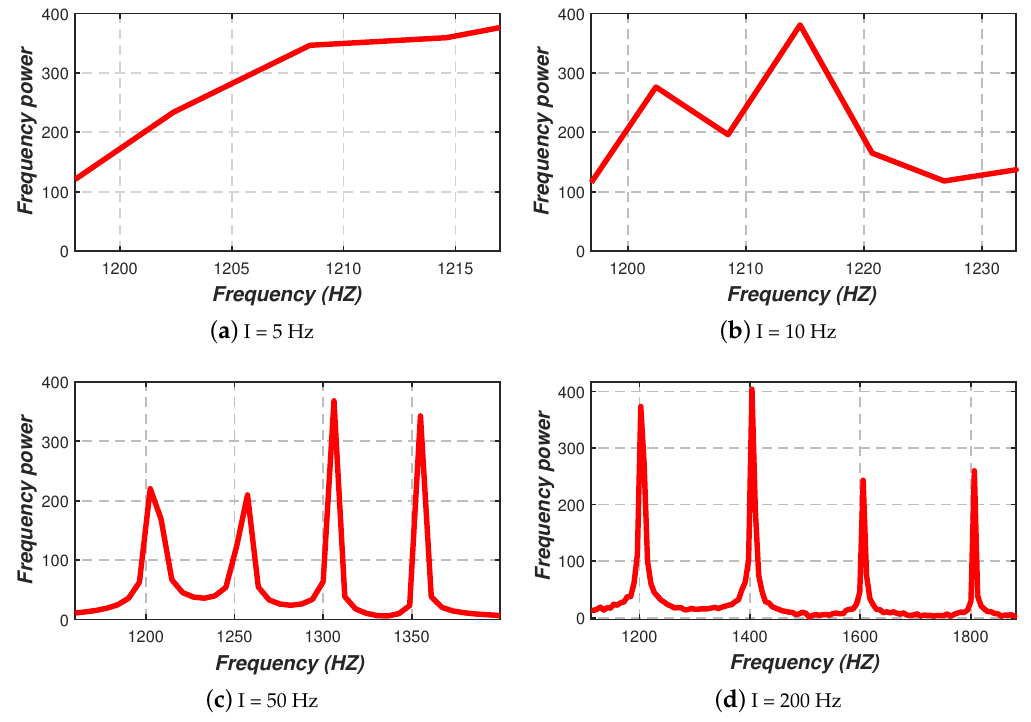
Figure 4. The effect of different adjacent frequency intervals on frequency recognizing, where I represents the adjacent frequency